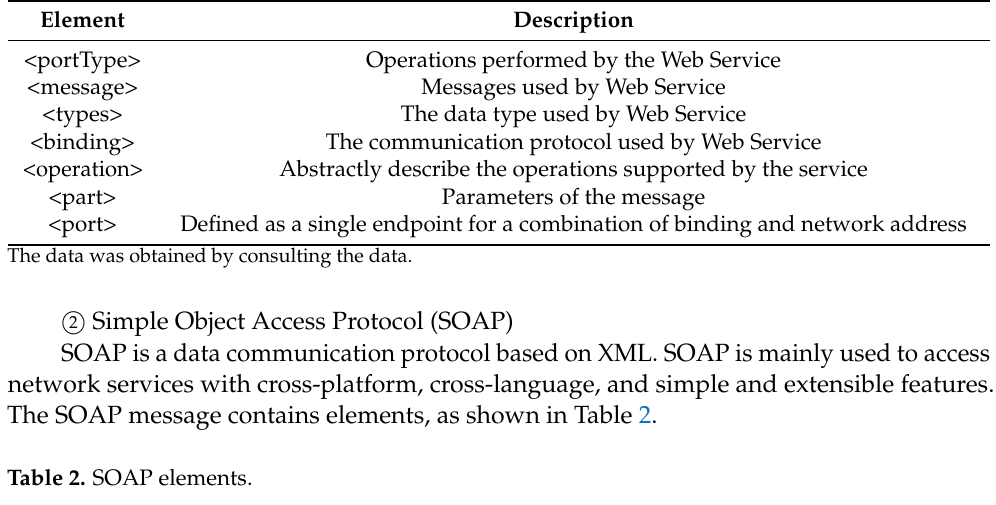
Table 1. Description of WSDL